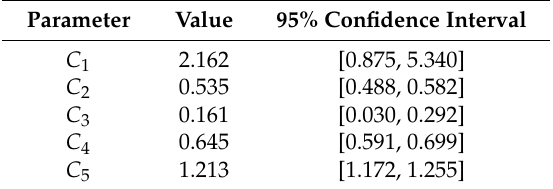
Table 4. MLR fitted exponents C 1 to C 5 of Equation (10) and corresponding 95% confidence